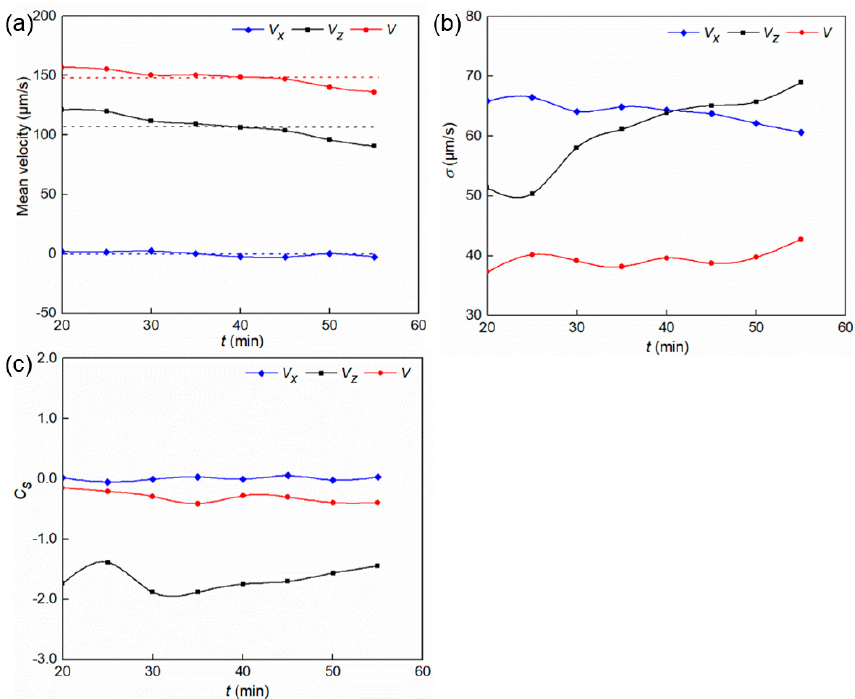
Figure 7. Statistical parameter of the swimming velocity V , V x , and V z and at different time: ( a ) mean velocity, ( b ) standard deviations ( σ ), and ( c ) deviation coefficient ( C s ).